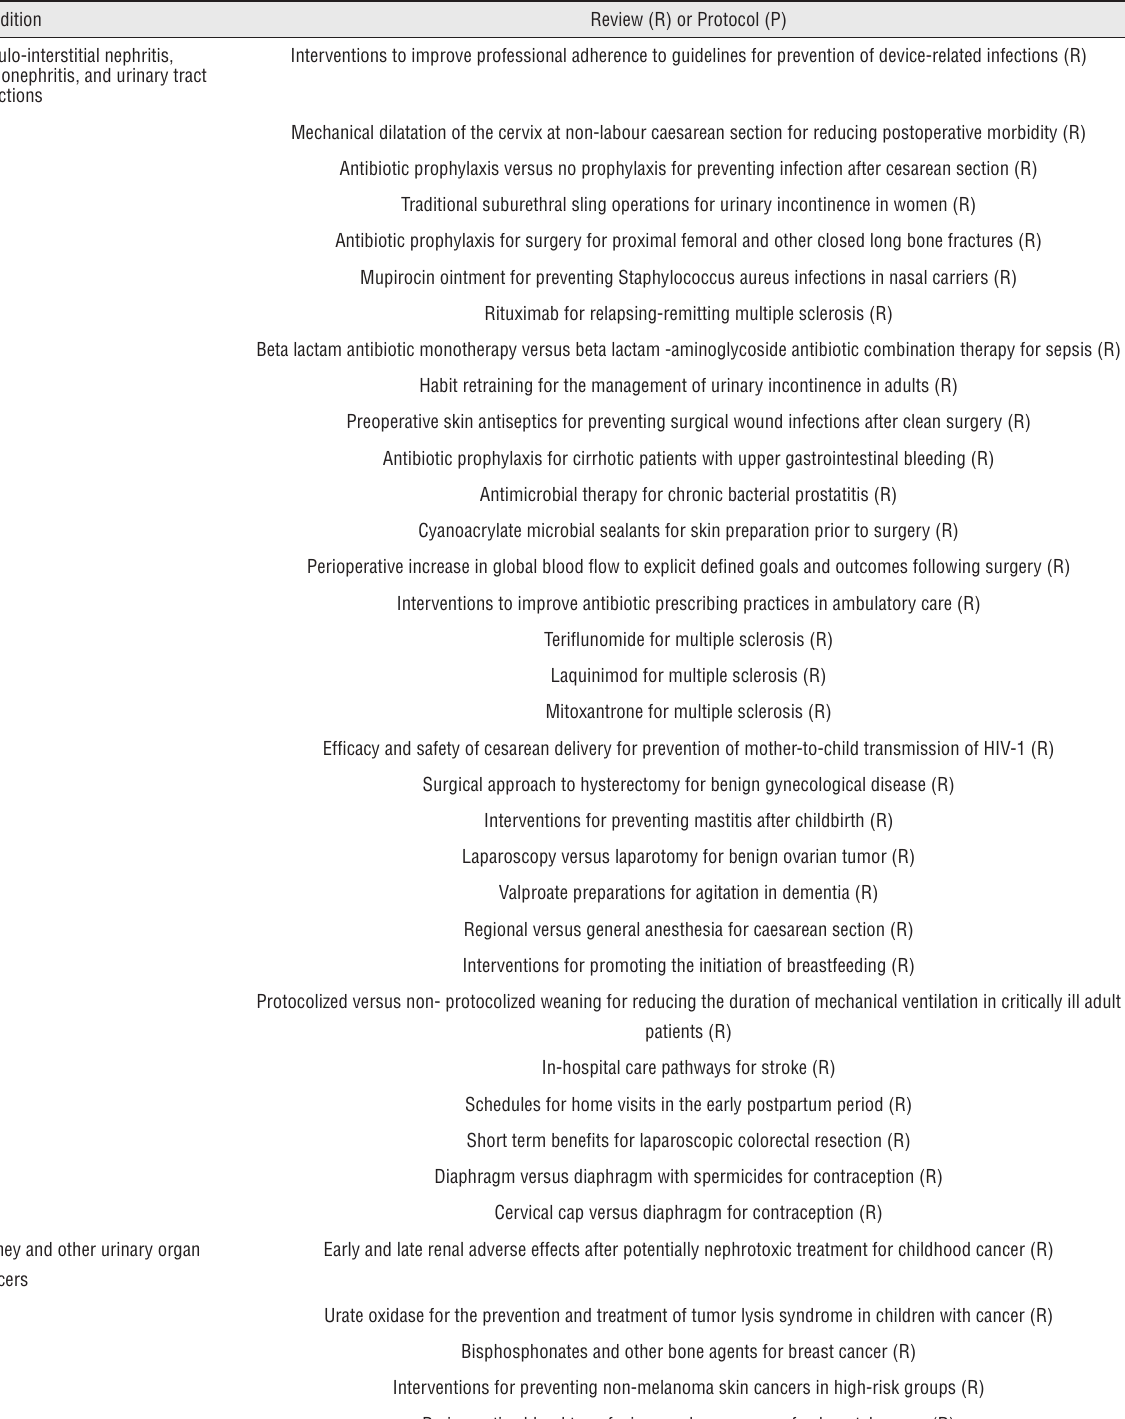
Supporting Table 2: Condition Review (R) or Protocol (P) Tubulo-interstitial nephritis, pyelonephritis, and urinary tract infections